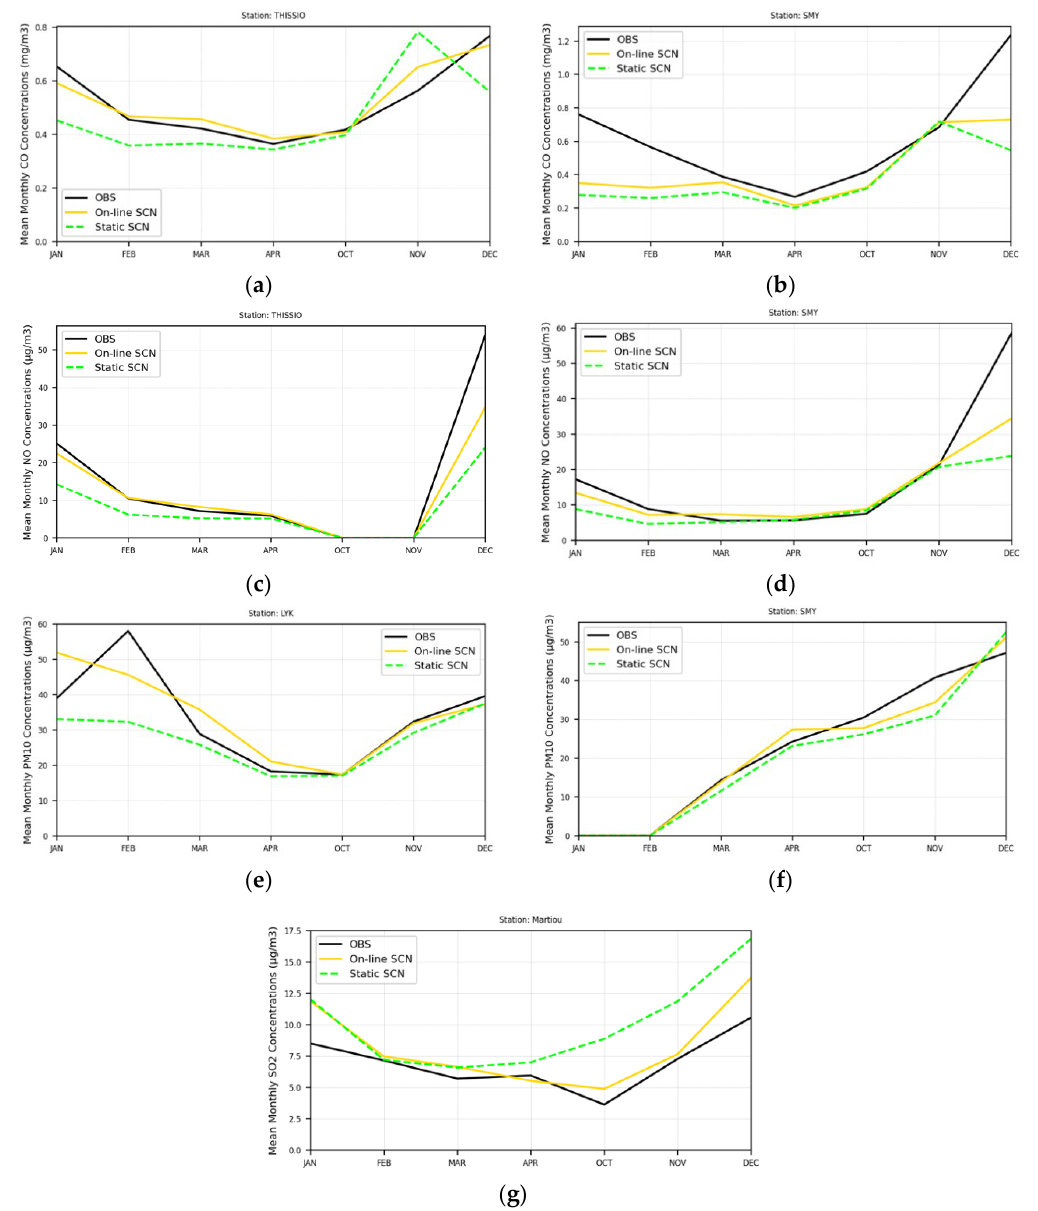
Figure 9. Comparison of CO ( a , b ), NO ( c , d ), PM10 ( e , f ) and SO 2 ( g ) mean monthly concentrations between observed and simulated data for on-line SCN and static SCN scenarios at different monitoring sites over Greece for the cold period of 2015 (January–April, October–December).